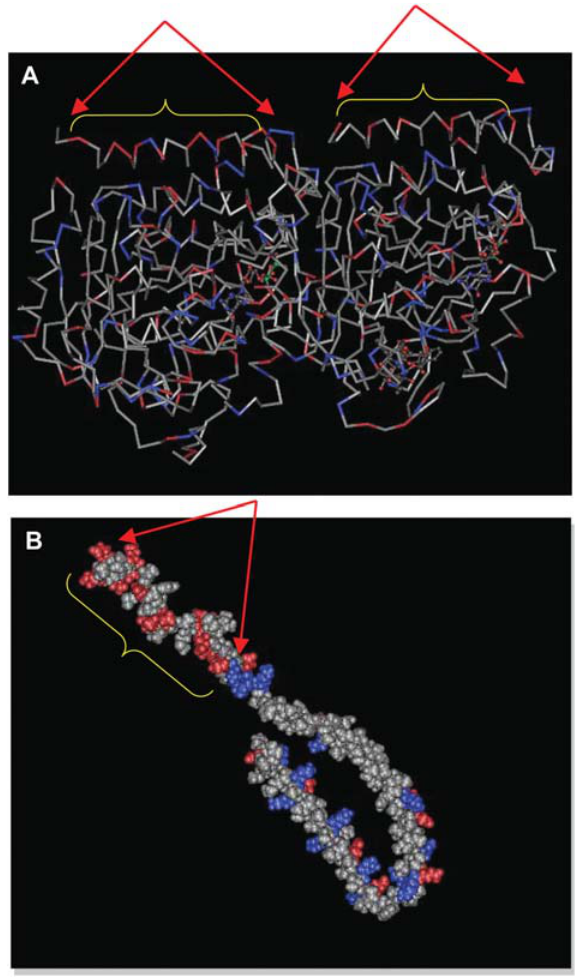
Figure 4 Crystal structures of tubulin and a -synuclein. 3D structures of the a / b -tubulin dimer w code 1TUB, (75) x (A) and the unfolded a -synuclein w code 1XQ8, (76) x (B). Acidic residues are colored in red, basic residues in blue; red arrows show the highly acidic C-terminal ends to which polyamines associate. The struc- tures are derived from the Modeling DataBase (MMDB), also known as ‘Entrez Structure’, a freely accessible database of exper- imentally determined structures obtained from the Protein Data Bank